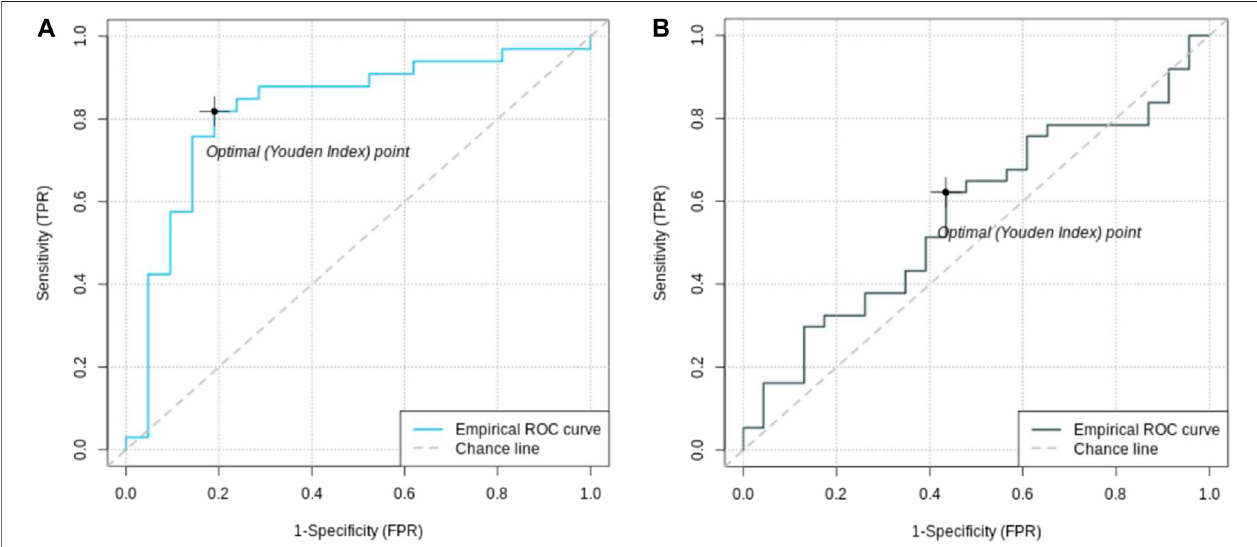
FIGURE 2 | Receiver operating characteristic (ROC) curves of feature selected machine learning model (A) and polygenic risk score (B) . The AUC of the feature selected model with 0.85 [95% CI (cid:1) (0.72; 0.96)] is better than the AUC of the PRS with 0.56 [95% CI (cid:1) (0.42; 0.81)].